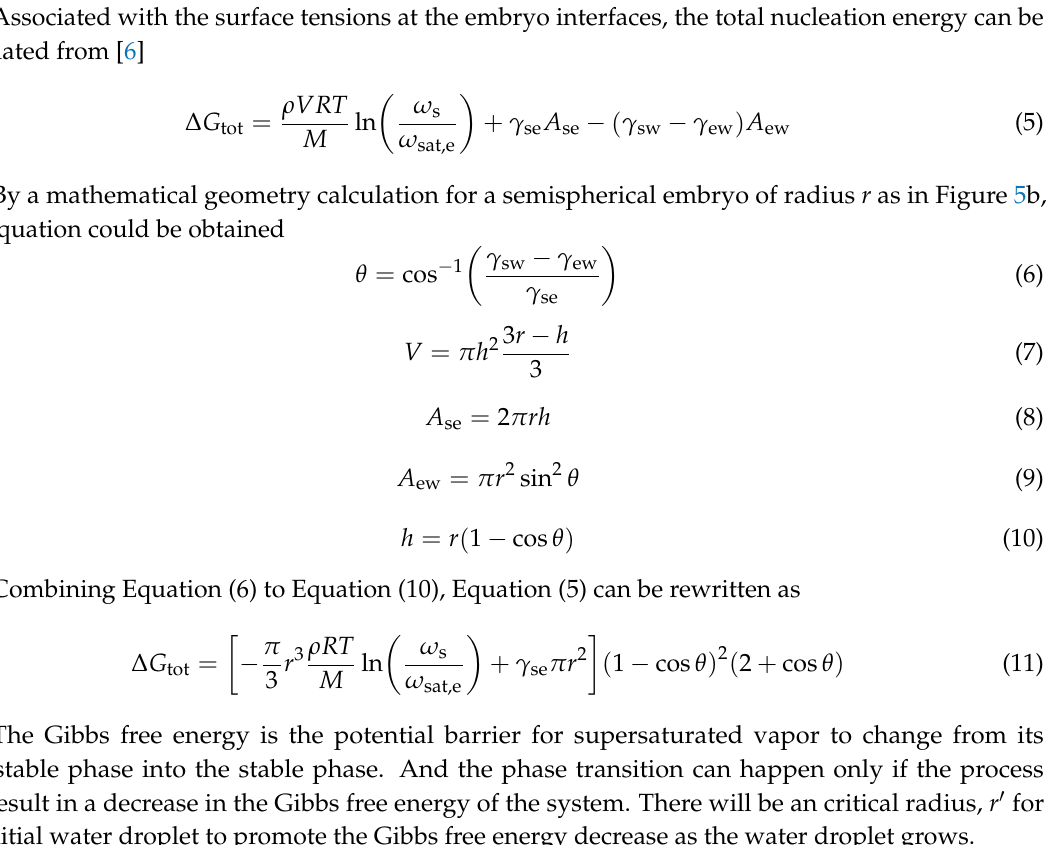
Figure 5. Schematic representation of a homogeneous ( a ) and a heterogeneous ( b ) nucleation [26]. Both surface area and volume of heterogeneous nucleation are smaller than homogeneous nucleation, which is mainly caused by surface tension at the three interfaces. As a consequence, the energy required to initiate the nucleation process is lower.